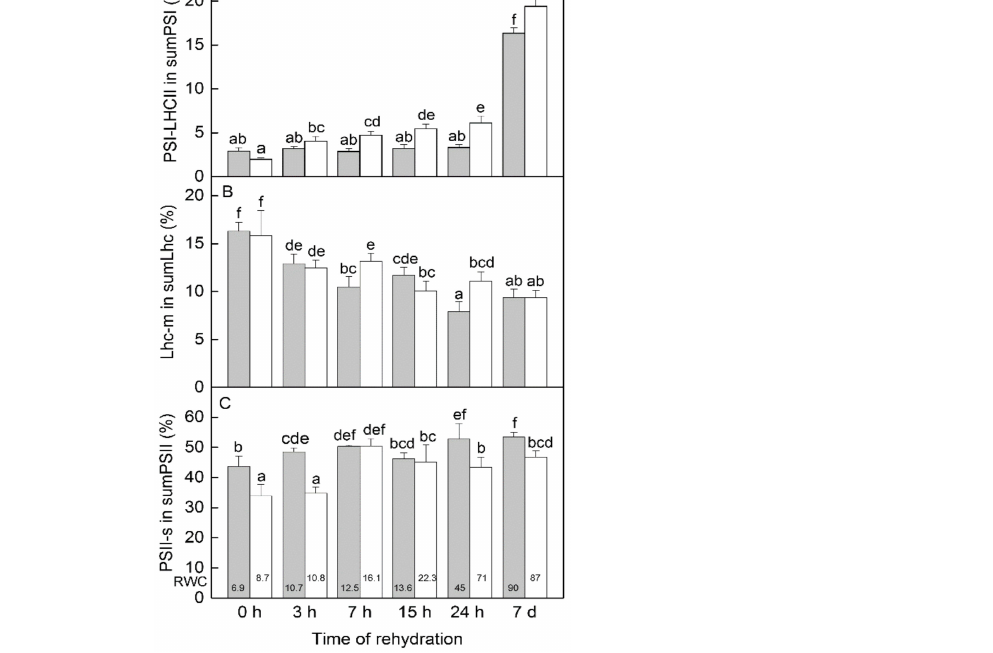
Figure 6. Changes in the proportion of the given assembly forms of thylakoid complexes in H. rhodopensis during the recovery from drought—(RAD) and freezing-induced desiccation (RAF) as a function of the time of rehydration. ( A ) Percentage of PSI-LHCII assembly form/band in the sum of all PSI forms/bands (PSI-megacomplex + PSI-LHCII + PSI + PSI-core = 100%); ( B ) Percentage of Lhc-m in sum free Lhc (LHCII-a + LHCII-t + Lhc-m = 100%); ( C ) Percentage of PSII-(mega-) and supercomplexes in sum PSII ((PSII-mega) + PSII-s + PSII-d + PSII-m = 100%). Thylakoids (500 µ g chlorophyll mL − 1 ) were solubilized using 1% ( w / V ) β -DM plus 1% ( w / V ) digitonin, and complexes were separated in 4.3–12% Blue Native gel gradients. PS—photosystem; LHC/Lhc—light-harvesting complex; s—supercomplex; m—monomer. Values are given as mean ± SE. Changes between RAD and RAF were statistically compared. The same letters within a graph indicate no significant differ- ences assessed by the Fisher LSD test ( p ≤ 0.05) after performing ANOVA. The RWC of plants at each time point, presented in %, are shown at the bottom of the columns. Table 2. Changes in the main photosynthetic proteins of H. rhodopensis plants during rehydration after drought-induced desiccation (RAD). 8%—dried plant; 3, 7, 15 and 24 h—hours after rehydration; 7 d—7 days after rehydration. The abundances of proteins are presented in percentage of the dried plants’ values (8% RWC). Values are given as mean ± SE. The same letters within a graph indicate no significant differences assessed by the Fisher LSD test ( p ≤ 0.05) after performing ANOVA. The changes in the content of the respective protein between RAD and RAF (Table 3) were statistically compared.